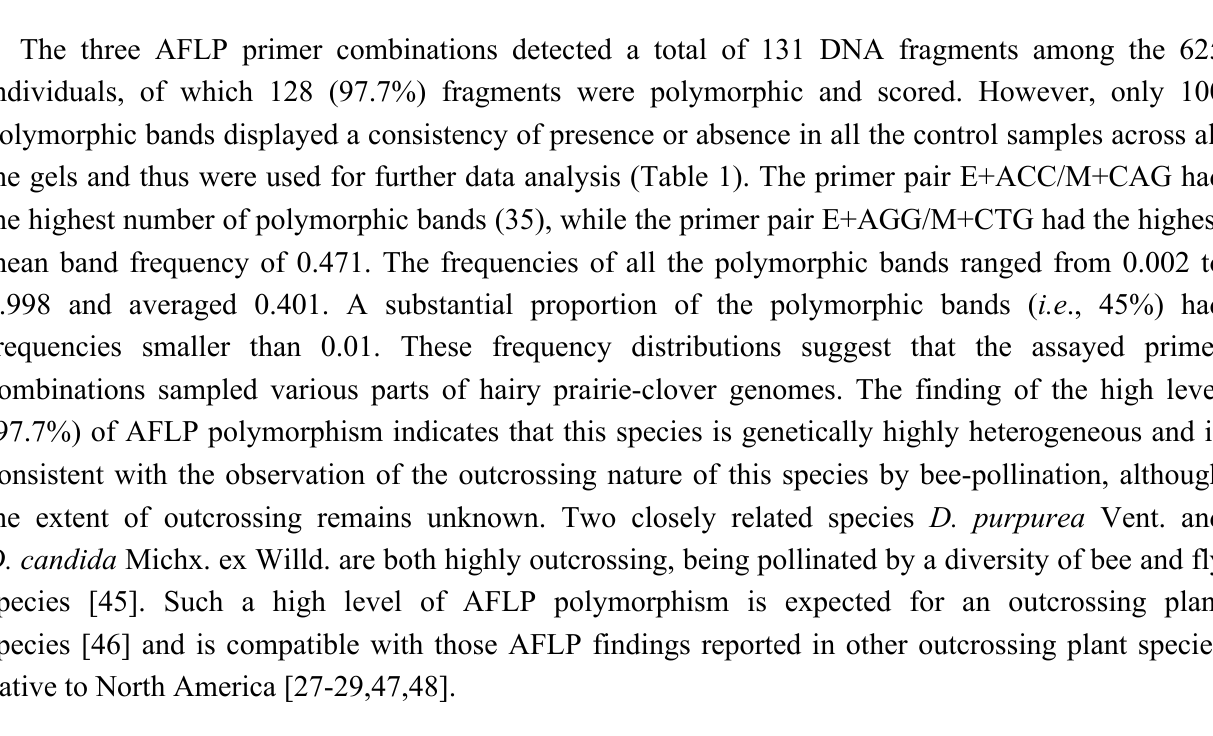
Table 1. Patterns of amplified fragment length polymorphism (AFLP) in the remnant population of hairy prairie-clover with respect to AFLP primer